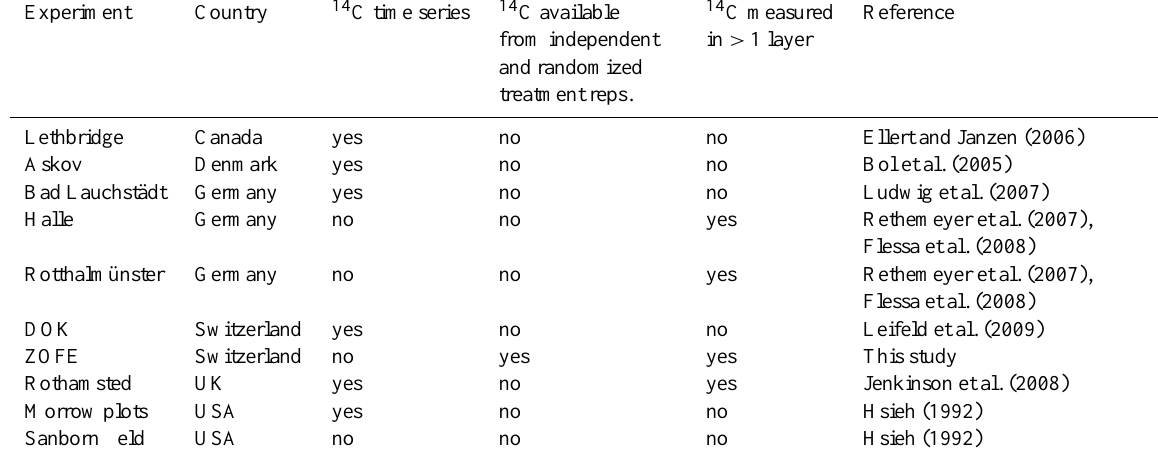
Table 1. Long-term agricultural field experiments where radiocarbon was used to derive soil carbon turnover estimates. Experiment Country 14 C time series 14 C available